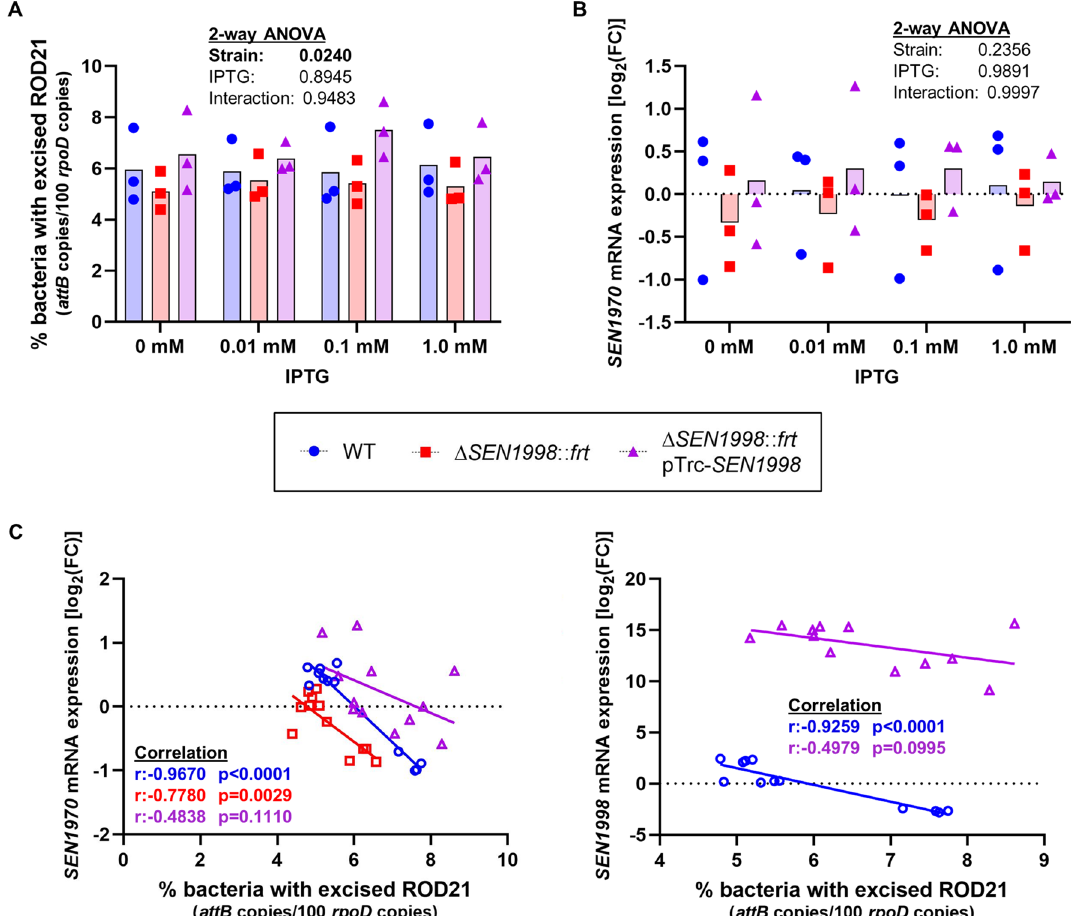
Figure 6. Effect of the absence and overexpression of SEN1998 and correlation of the excision with the SEN1970 and SEN1998 expression. ( A ) Excision levels of ROD21, represented as the percentage of the bacterial population with an empty attB site, in Salmonella ser. Enteritidis P125109, Δ SEN1998 :: frt and Δ SEN1998 :: frt pTrc- SEN1998 , grown in the presence of different concentrations of IPTG. ( B ) mRNA levels of the integrase- encoding gene SEN1970 in the three strains, relative to the levels in P125109. Bars in A and B represent the mean of three biological replicates (individual points), at a specific IPTG concentration. ( C ) Scatter plot of the relative SEN1970 (left panel) and SEN1998 (right panel) mRNA levels versus the excision level in the same sample for the three Salmonella strains. The Pearson correlation coefficient and p-value are shown for each